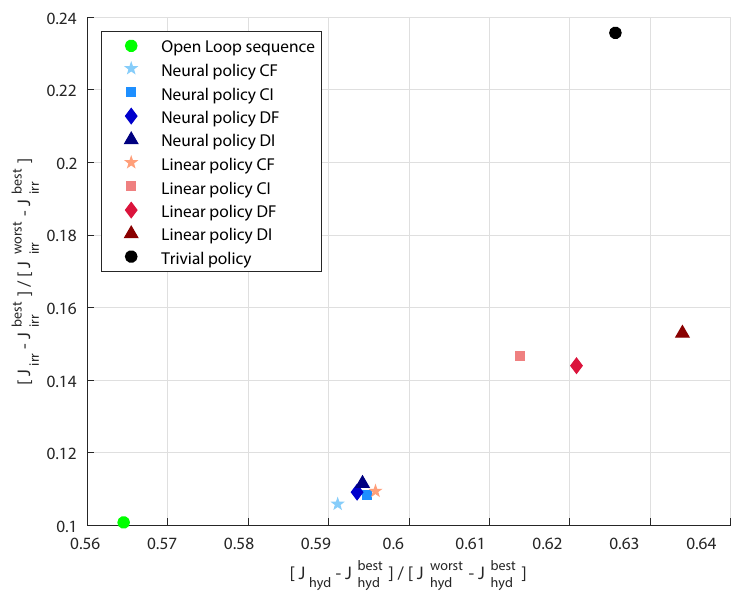
Figure 8. Representation of the objective space with the ten considered control systems. Table 4. Improvements over the solution obtained with the trivial closed-loop policy for all the considered cases, expressed as percentage of the distance between this solution and the optimal open-loop release